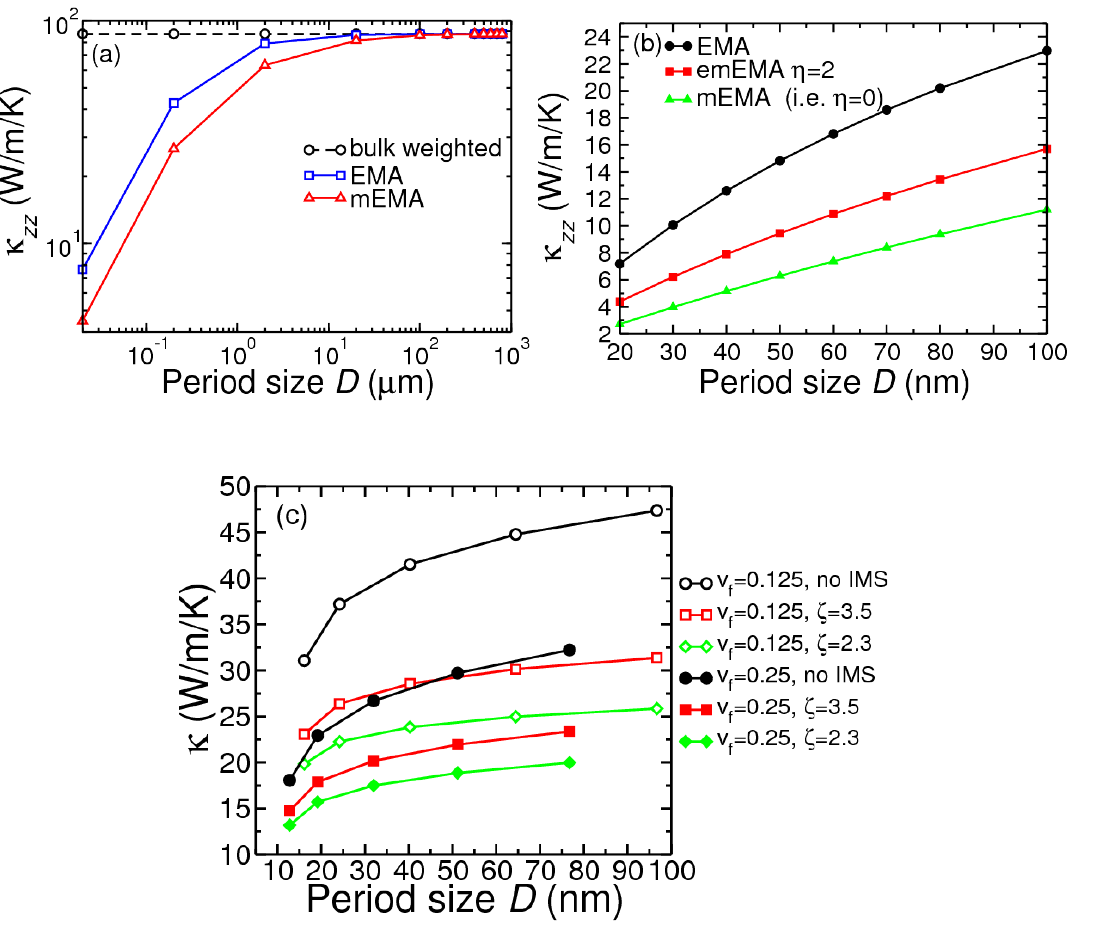
Figure 6. Panels ( a , b ): Comparison of period size dependence of room-temperature cross-plane conductivity for Si( D /2)/Ge( D /2) PSL using the EMA, mEMA and emEMA methods. Panel ( c ): Period and volume fraction dependence of κ for Ge ND inserts in Si matrix. Sample size is 1 mm for panel ( a ) and 500 nm for panels ( b , c